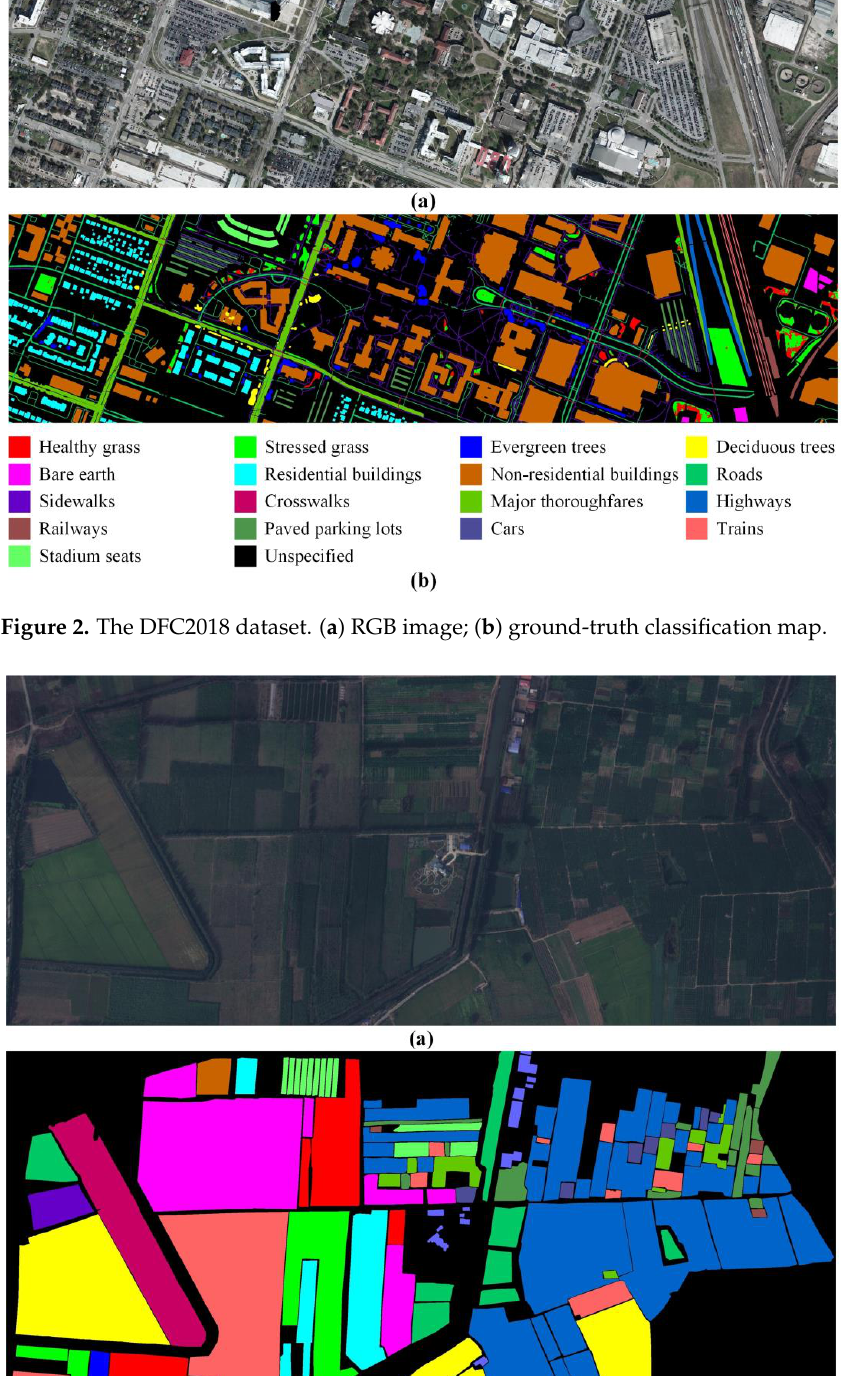
Figure 3. The Xiongan dataset. ( a ) three-band false color composite; ( b ) ground-truth map.